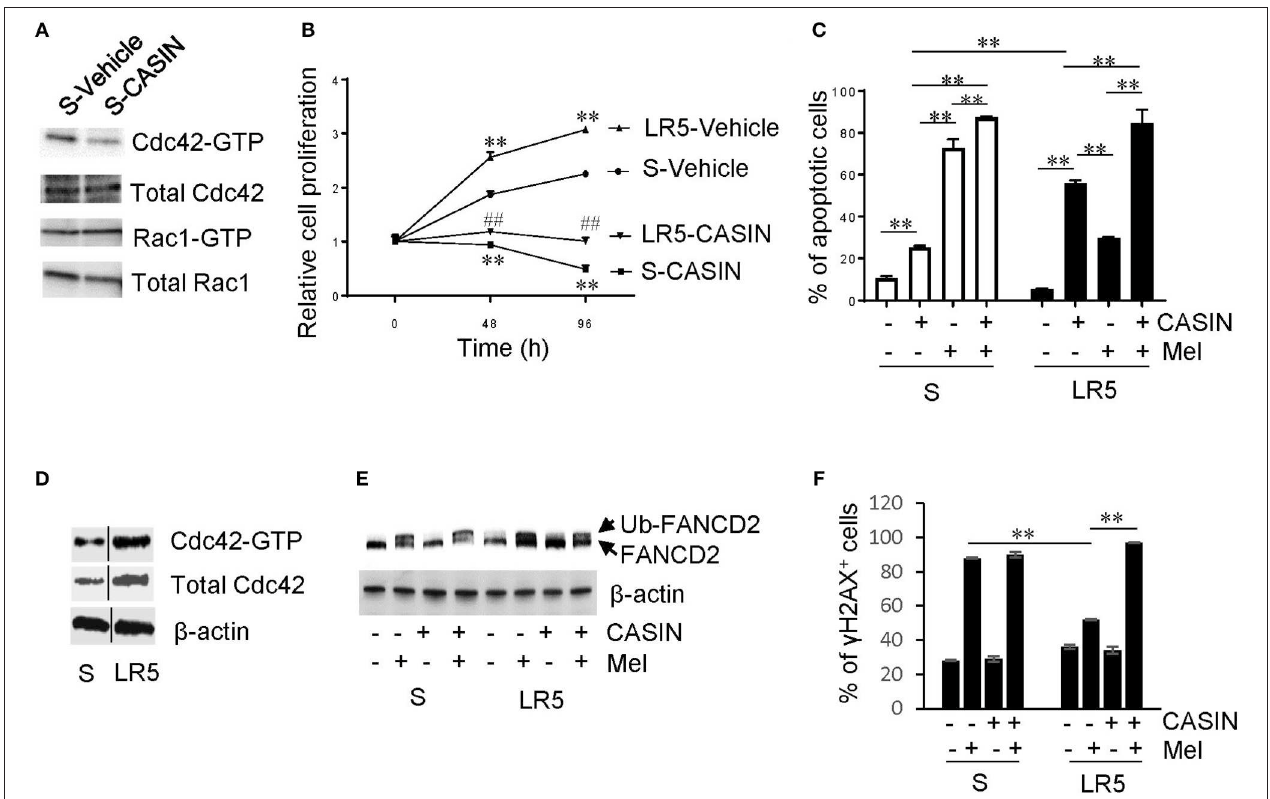
FIGURE 3 | Effects and mechanism of action of CASIN on melphalan-resistant MM cells. (A) CASIN reduces Cdc42 activity (Cdc42-GTP) but not Rac1 activity (Rac1-GTP). Melphalan-sensitive MM cells (S) were treated with Vehicle or CASIN (5 µ M) for 8h. Cdc42 and Rac1 activities were measured using pull-down assay. (B) CASIN (5 µ M) inhibits proliferation of both S and melphalan-resistant (LR5) MM cells. ** P < 0.01 vs. S-Vehicle; ## P < 0.01 vs. LR5-Vehicle. (C) CASIN (5 µ M) preferentially causes apoptosis of melphalan-resistant MM cells. S and LR5 cells were treated with or without CASIN or melphalan (Mel, 25 µ M) or both for 2 days. Annexin V + cells were analyzed using flow cytometry. ** P < 0.01. (D–F) Mechanism of action of CASIN on melphalan-resistant MM cells. (D) Cdc42 activity and expression are increased in LR5 cells compared to that in S cells. Cdc42 activity was measured using pull-down assay. β -Actin was used as loading control. Vertical lines indicate the gel lanes being switched in position from the original blots. (E) CASIN (5 µ M) decreases melphalan-induced FANCD2 mono-ubiquitination (Ub-FANCD2) in LR5 but not in S cells. S and LR5 cells were treated with or without CASIN, Mel (25 µ M), or both for 16h. FANCD2 was detected using western blotting. β -Actin was used as loading control. (F) CASIN sensitizes melphalan-resistant but not -sensitive MM cells to melphalan-induced DNA damage. γ H2A histone family member X-positive ( γ H2AX + ) cells were detected using flow cytometry. ** P < 0.01. Error bars represent means ± SD of triplicates and data are representative of three independent